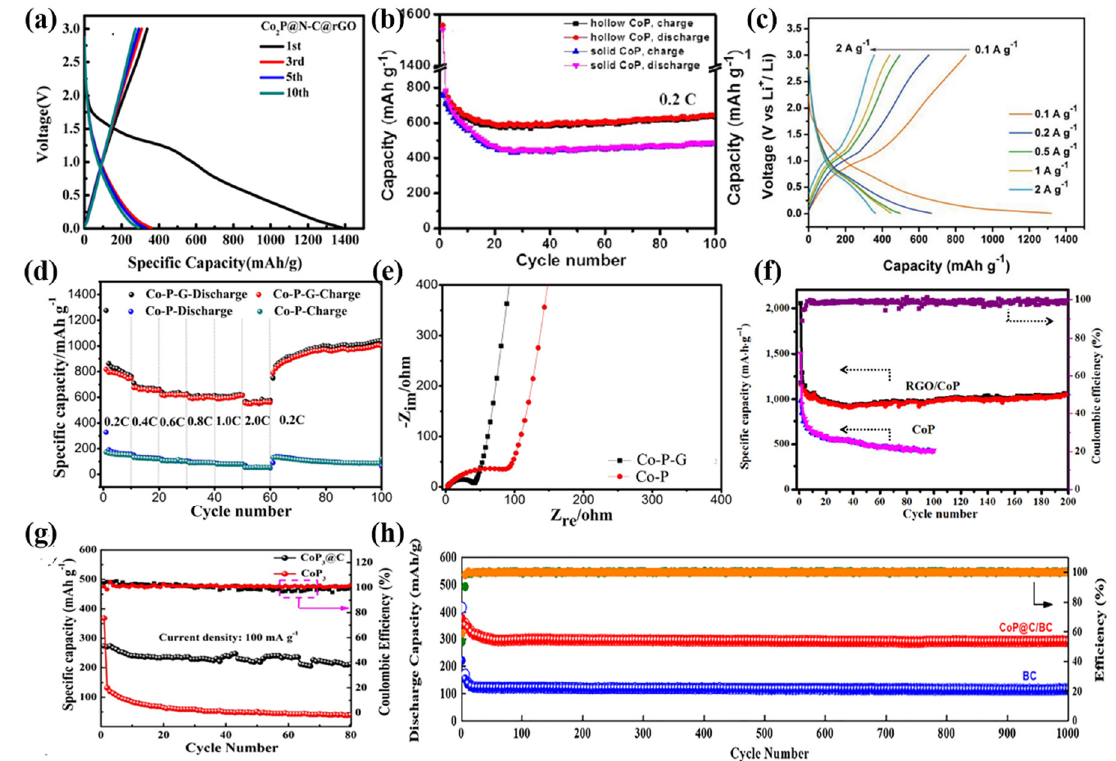
Figure 12. Electrochemical performances of cobalt-based anode materials. ( a ) Charge-discharge profiles of Co 2 P@N-doped C (N-C)@reduced graphene oxide (rGO) in various cycles [143]. ( b ) Cycle performances of CoP hollow and solid nanoparticles [79]. ( c ) Charge-discharge profiles of N, P co-doped porous carbon sheet (CoP ⊂ NPPCS) hybrids at various current densities [141]. ( d ) Rate performances and ( e ) EIS spectra of Co 2 P-Co/graphene and Co 2 P-Co composites [139]. ( f ) Cycle performances of CoP/RGO and CoP [135]. ( g ) Cycle performances of CoP 3 @C and CoP 3 [80]. ( h ) Cycling performance of CoP@C/biomass-derived carbon (BC) and pure BC [142].